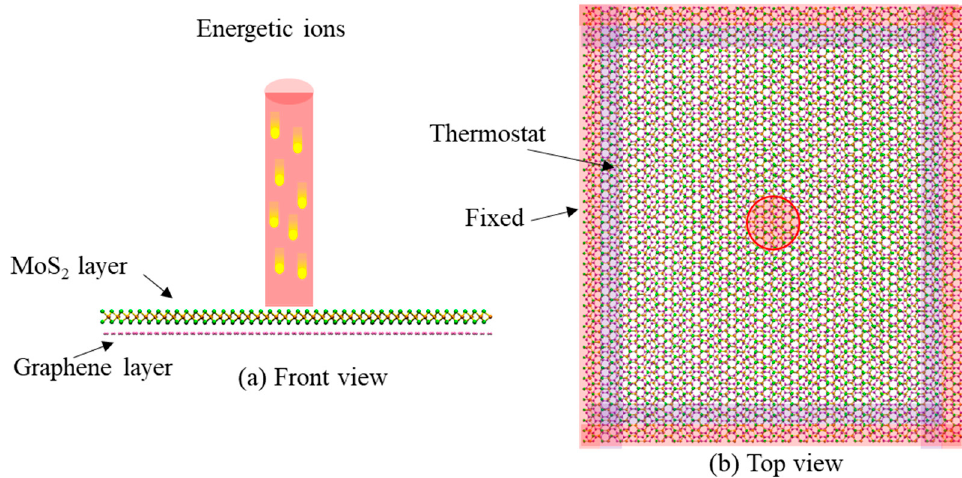
Figure 1. Simulation models of the M/G nanopore fabrication by ion beam irradiation. ( a ) Front view, and ( b ) top view.